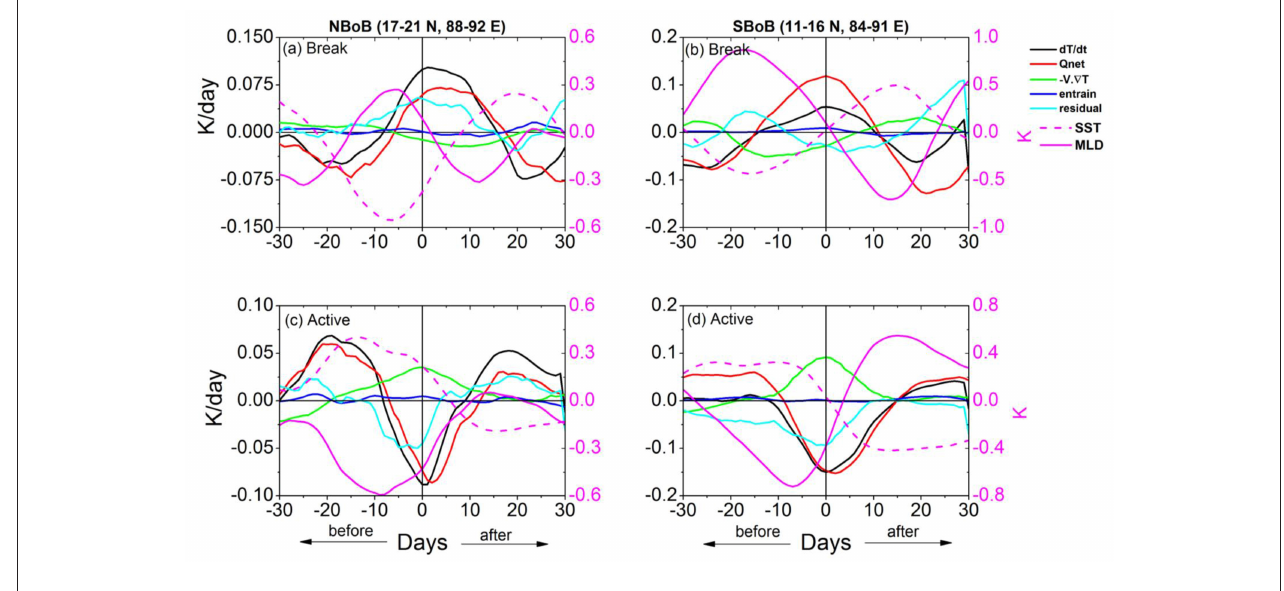
FIGURE 9 | Same as Figure 8 , but for composites over NBoB and SBoB.